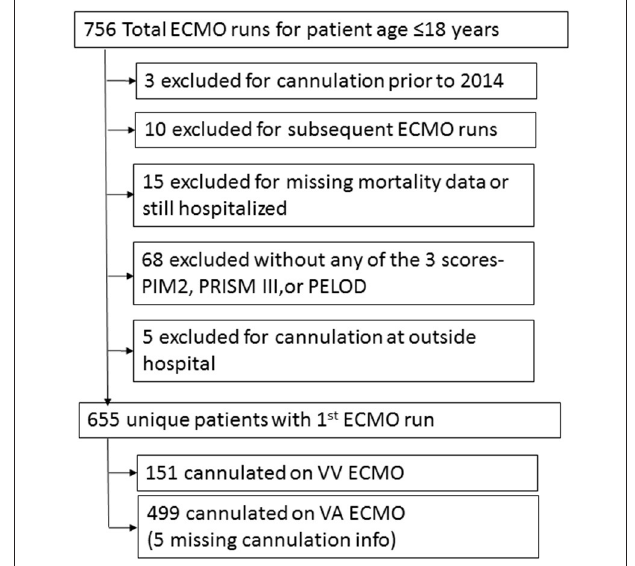
FIGURE 1 | Study inclusion and exclusion flow